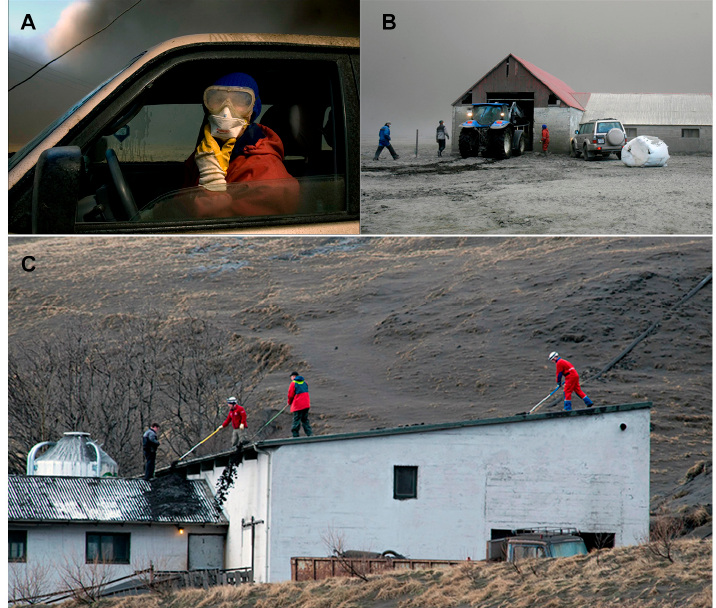
Eyjafjallajökull eruption: ( A ) eye and mouth protection, rapid personal transport vehicles (from http:// www.16lovers.com/syningar/nigeriusvindlid/islandssvindlid/bref-1-volcanic-eruption/); ( B ) heavy machinery, plastic seals for fodder, spacious and fairly tight buildings (from http://blogs.sacbee.com/ photos/2010/04/iceland-volcano-part-two.html); ( C ) running water, safety equipment, electricity (from